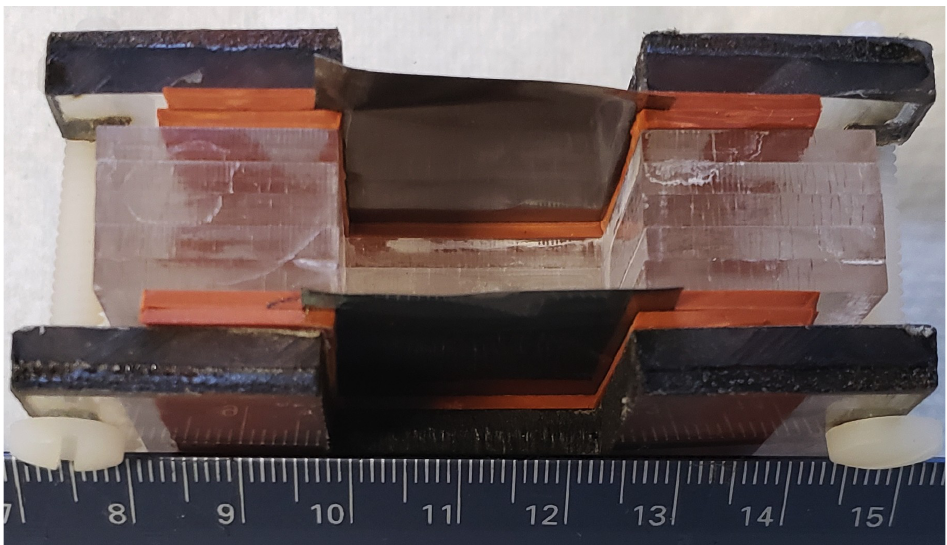
Figure 1. Standard 20 mm capacitor—this capacitor was constructed from two 3 cm × 3 cm × 0.1 mm Ti sheet electrodes, separated by 20 mm. The body of the capacitor was composed of Mylar sheets, and the electrodes were held in place by waterproof rubber (red) gaskets. Plastic screws were used instead of metal to reduce corrosion during immersion experiments. In the configuration shown, after a charge to 10 V, the measured discharge time for the lowest allowed programmable current, 1 × 10 − 5 amps, was 0.0005 s. This value should be compared to the discharges shown in Figure 2. The only di ff